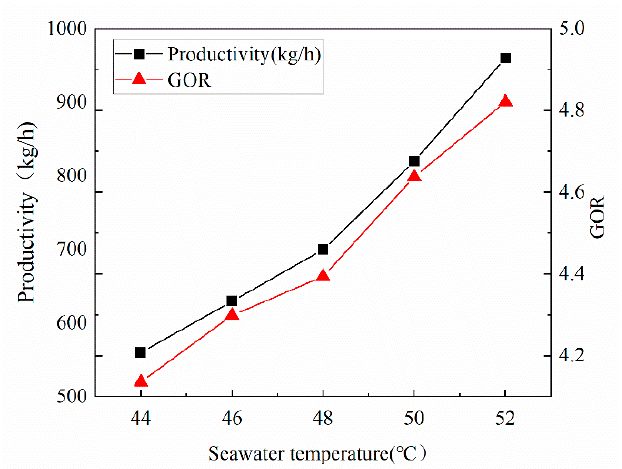
Figure 4. Effect of seawater temperature on system productivity and gained output ratio (GOR).